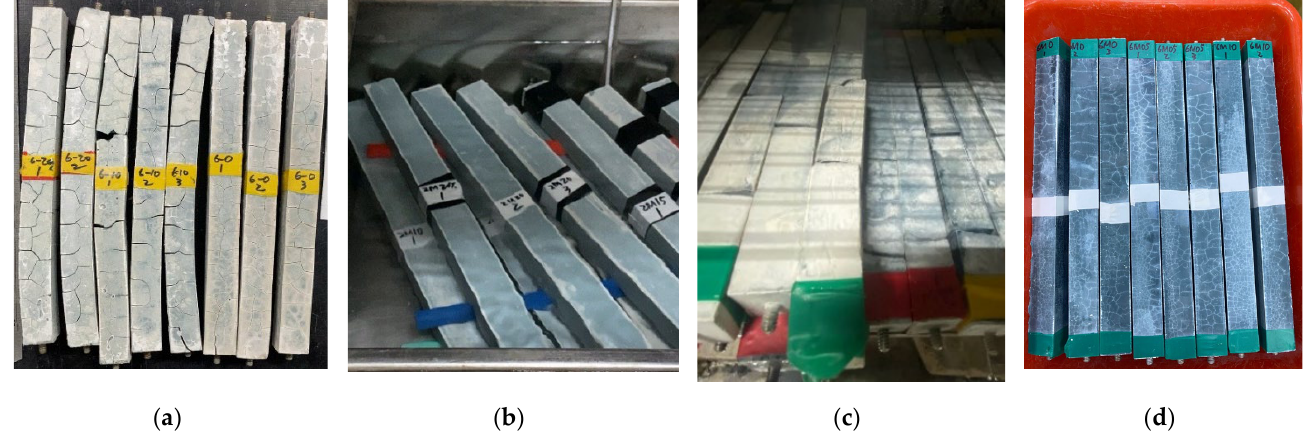
Figure 3. The appearance of GP specimen cured in three environments at the age of 7 days. ( a ) Air-dry; ( b ) Water bath; ( c ) Steam; ( d ) Room temperature. Table 4. The length change ratios of the specimens unmolded at the age of 3